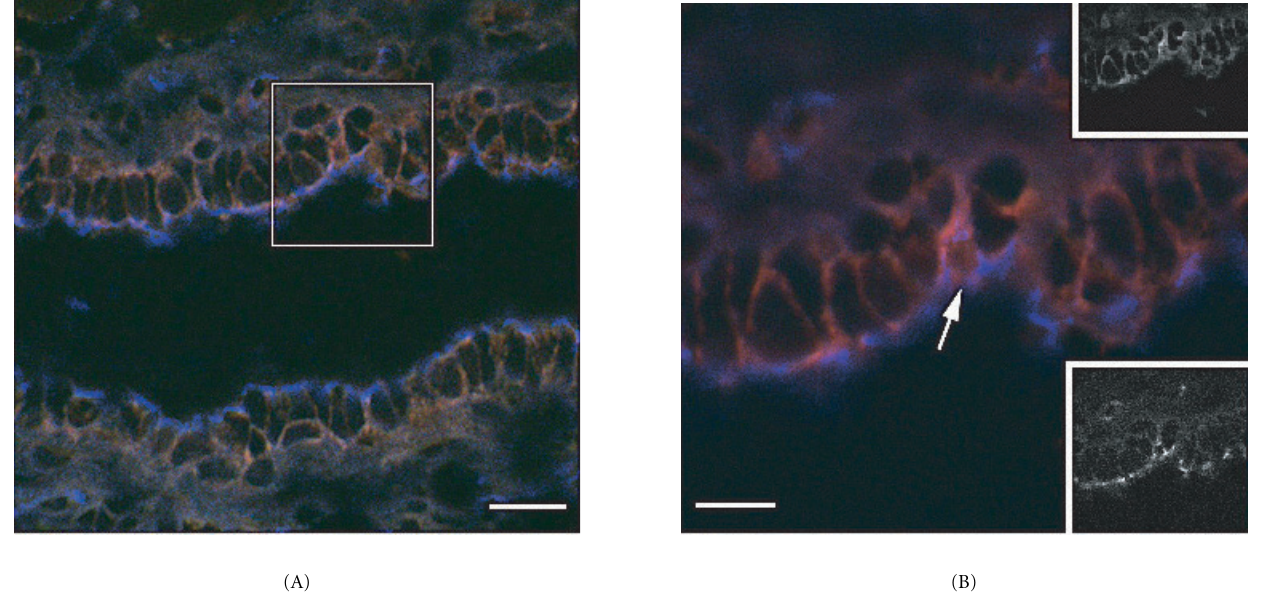
Figure 5: Detection of ZO-1 protein and bright TLC-LRCs in the 8 week-old C57 Bl6N mammary duct. (A) Co-localization of ZO-1 protein (blue) and bright LRC (red). (B) High power magnification of area shown in (A) (arrow). Note bright LRCs and ZO-1 expression around the polarized cell borders. Upper inset in (B) TRITC-rhodamine channel (red) showing bright TLC-labeled cell (arrow) and lower inset, AMCA-UV channel showing ZO-1 protein expression. Scale bar in (A) 90 µ m and (B) 190 µ